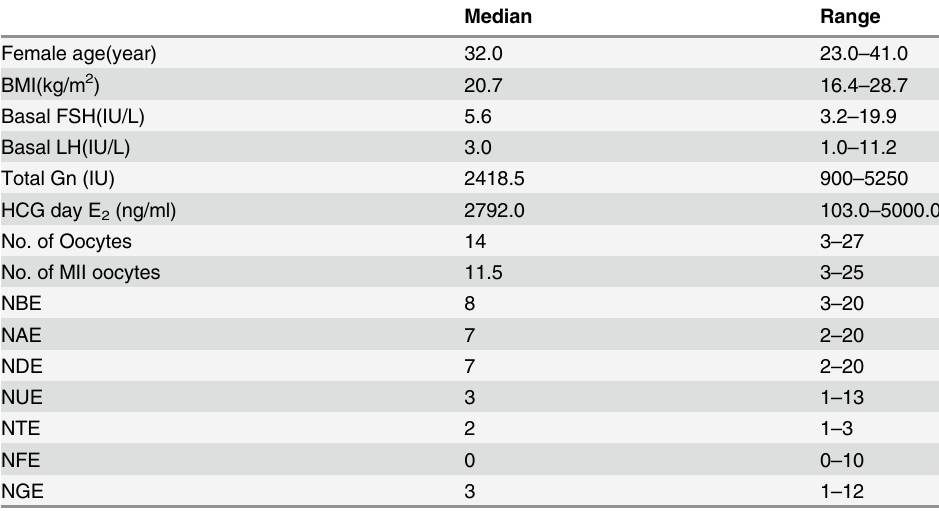
Table 6. Clinical characteristics of PGD cycles of monogenic diseases.